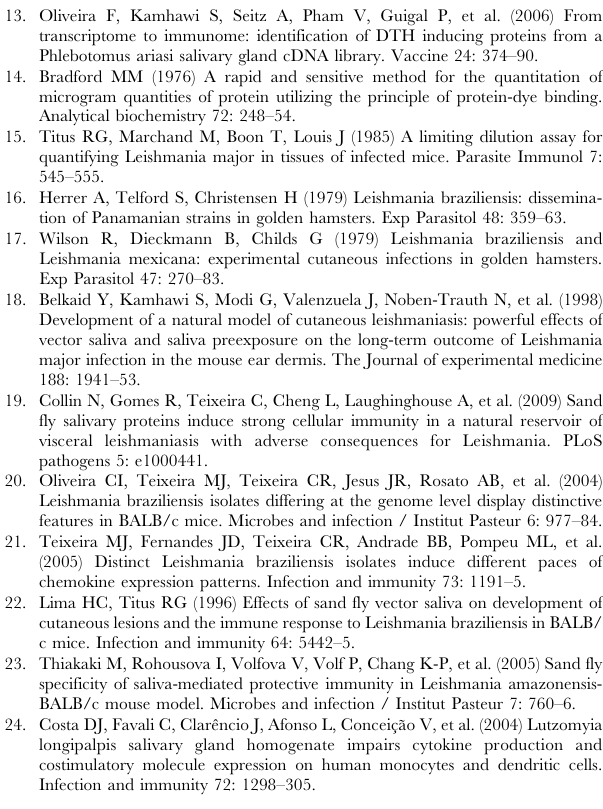
Figure S1 Production of antibody against saliva in serum samples from hamsters immunized with L. longipalpis SGS or LJM19 DNA plasmid. Hamsters were inoculated three times in the right ear with Lu. longipalpis SGS (closed squares) or LJM19 DNA plasmid (closed triangles) or with saline (open squares). After 48 hours, the serum samples were collected and the total IgG against L. longipalpis SGS was measured by ELISA. Points represent each animal, experiments were repeated three times and were evaluated by Kruskal-Wallis non- parametric test. **p , 0.01; ***p , 0.001. Figure S2 Cytokine expression in lymph node cells from hamsters immunized with Lu. longipalpis followed by L. braziliensis infection. Hamsters were inoculated three times in the right ear with Lu. longipalpis SGS (closed symbols) or with saline (open symbols) and were challenged in the left ear with 10 5 L. braziliensis in the presence of Lu. intermedia (squares) or Lu. longipalpis SGS (circles). IFN- c , IL-10 and TGF- b relative mRNA expression was evaluated by Real-Time PCR at three (left column) and eight (right column) weeks after the infection. Points represent each animal, experiments were repeated three times and were evaluated by Mann-Whitney non-parametric t test. *p , 0.05. Figure S3 Parasite load in LJM19 immunized hamsters following infection with L. braziliensis . Hamsters (12 per